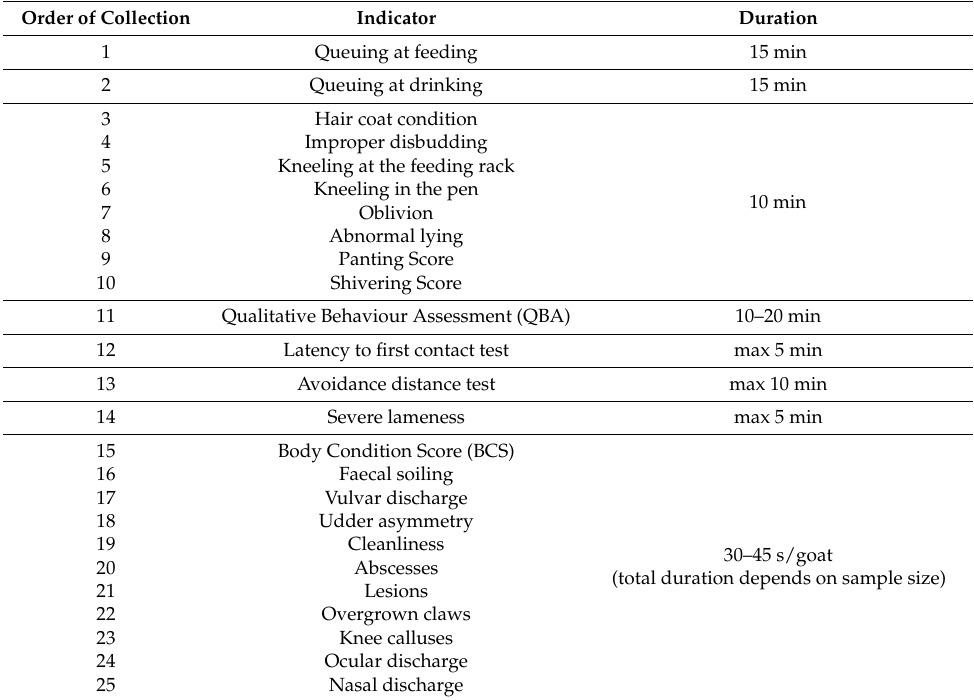
Table 1. Order of collection and duration of the time of data collection of the indicators included in the prototype of the AWIN (Animal Welfare Indicators)